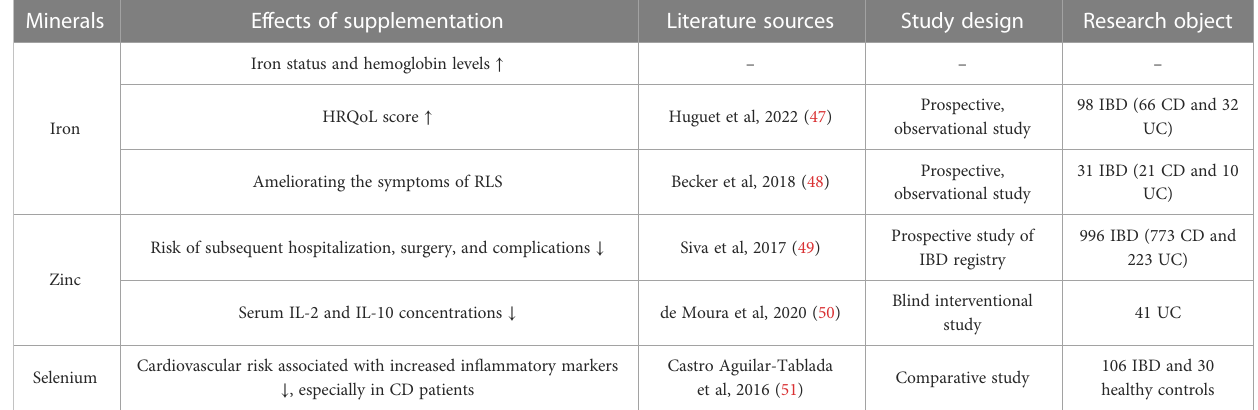
TABLE 2 Effects of mineral supplementation in